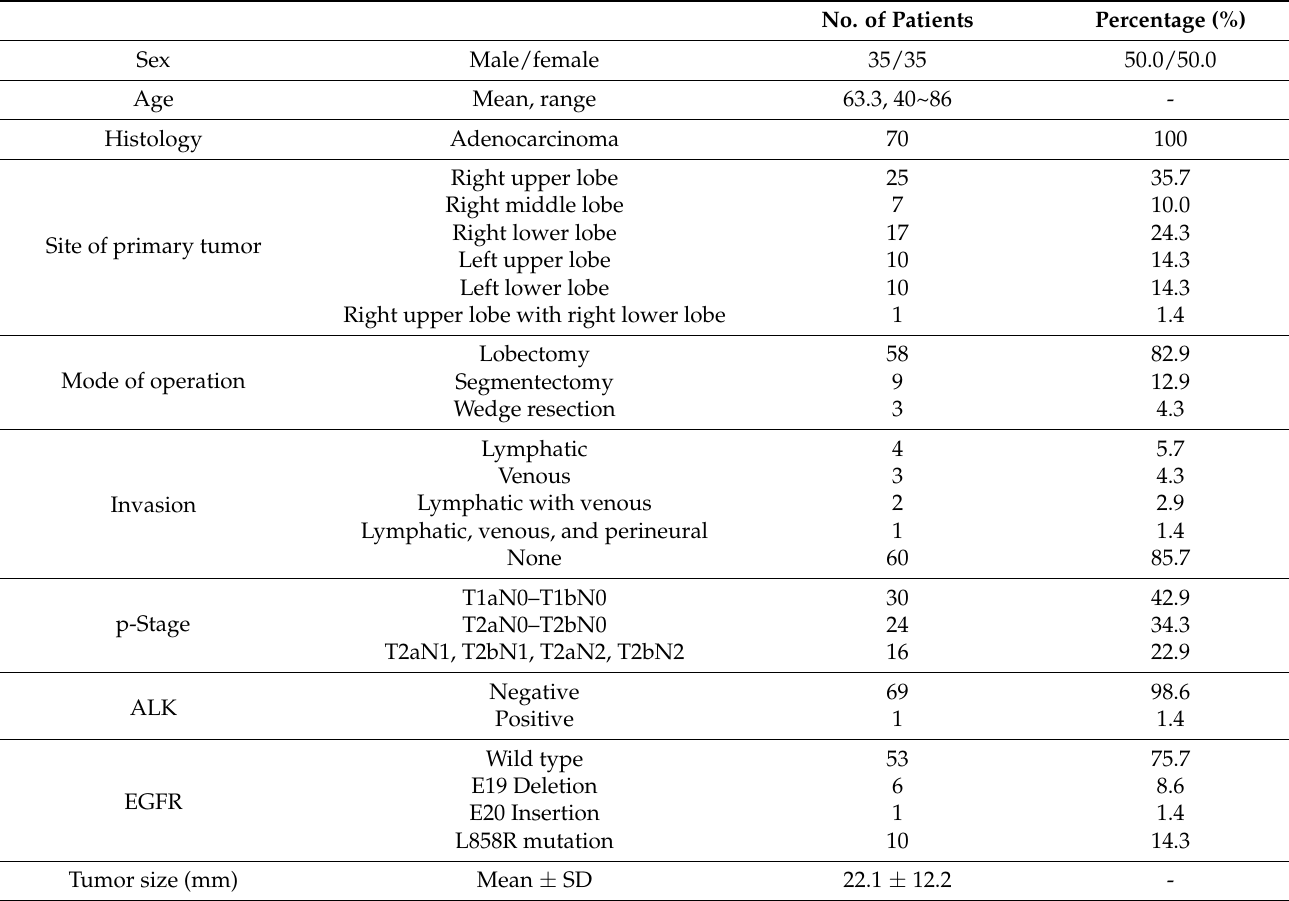
Table 1. Summary of clinical characteristics of patients with non-small cell lung